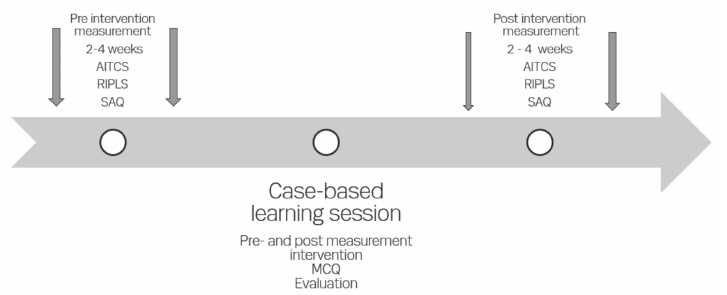
Figure 1. Timeline illustrating the distribution of questionnaires. AITCS – Assessment of Interpro- fessional Team Collaboration Scale. RIPLS – Readiness for Interprofessional Learning Scale. SAQ – Safety and Attitude Questionnarie. MCQ – Multiple Choice